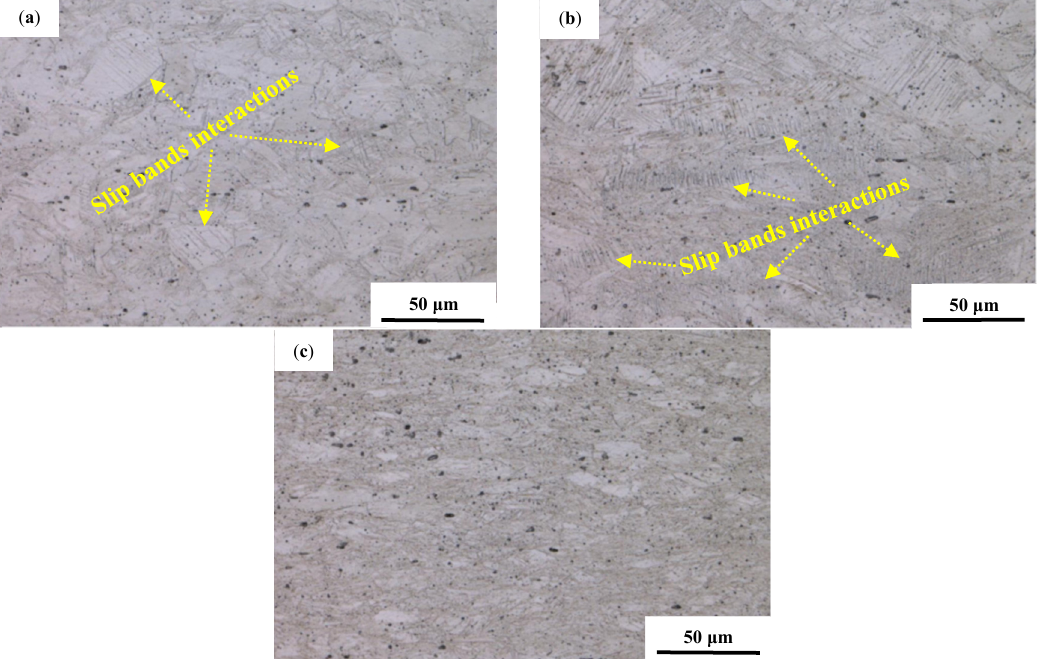
Figure 3. Metallographic structure of Fe-25Mn-3Si-3Al-0.3Nb steel after cold rolling ( a ) after 30% deformation; ( b ) after 50% deformation; ( c ) after 70% deformation.